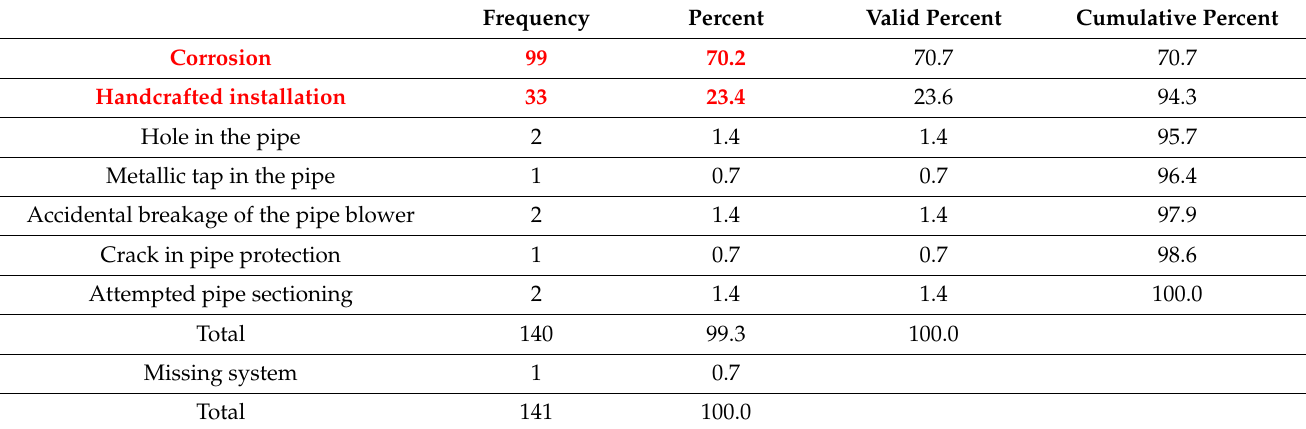
Table 7. Hierarchy of incident causes for 2017–2019.